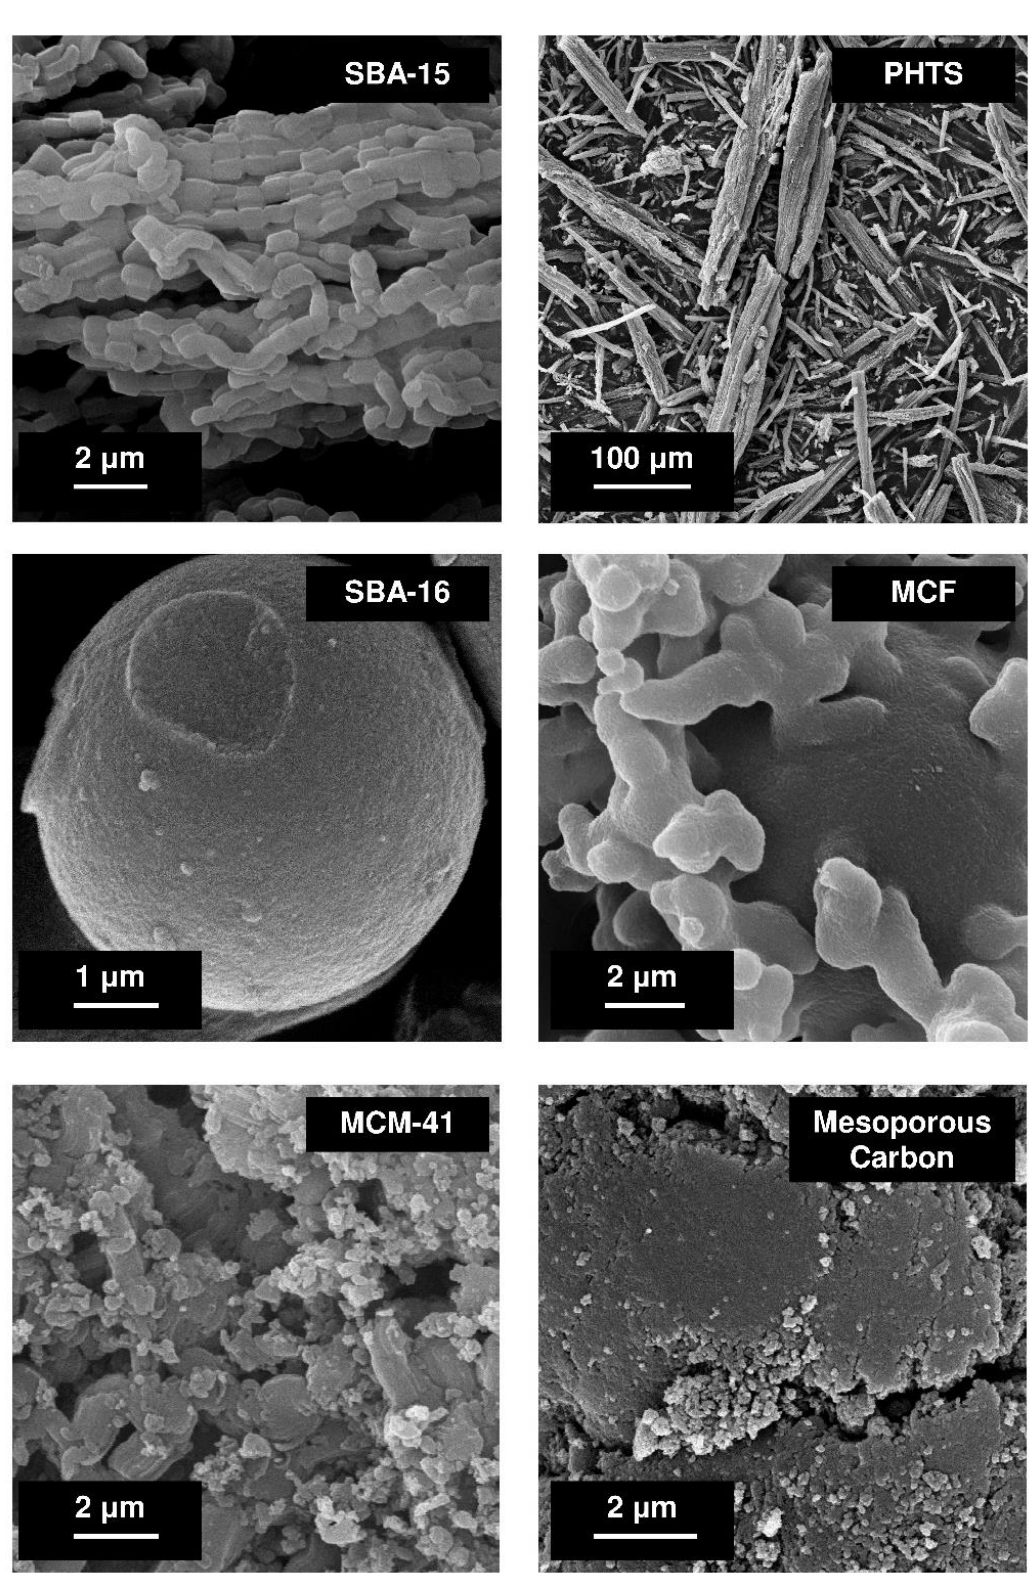
Figure 2. SEM images of various mesoporous materials. The micrographs were collected using Zeiss ELO-40 electron microscope come from the authors’ own collection.